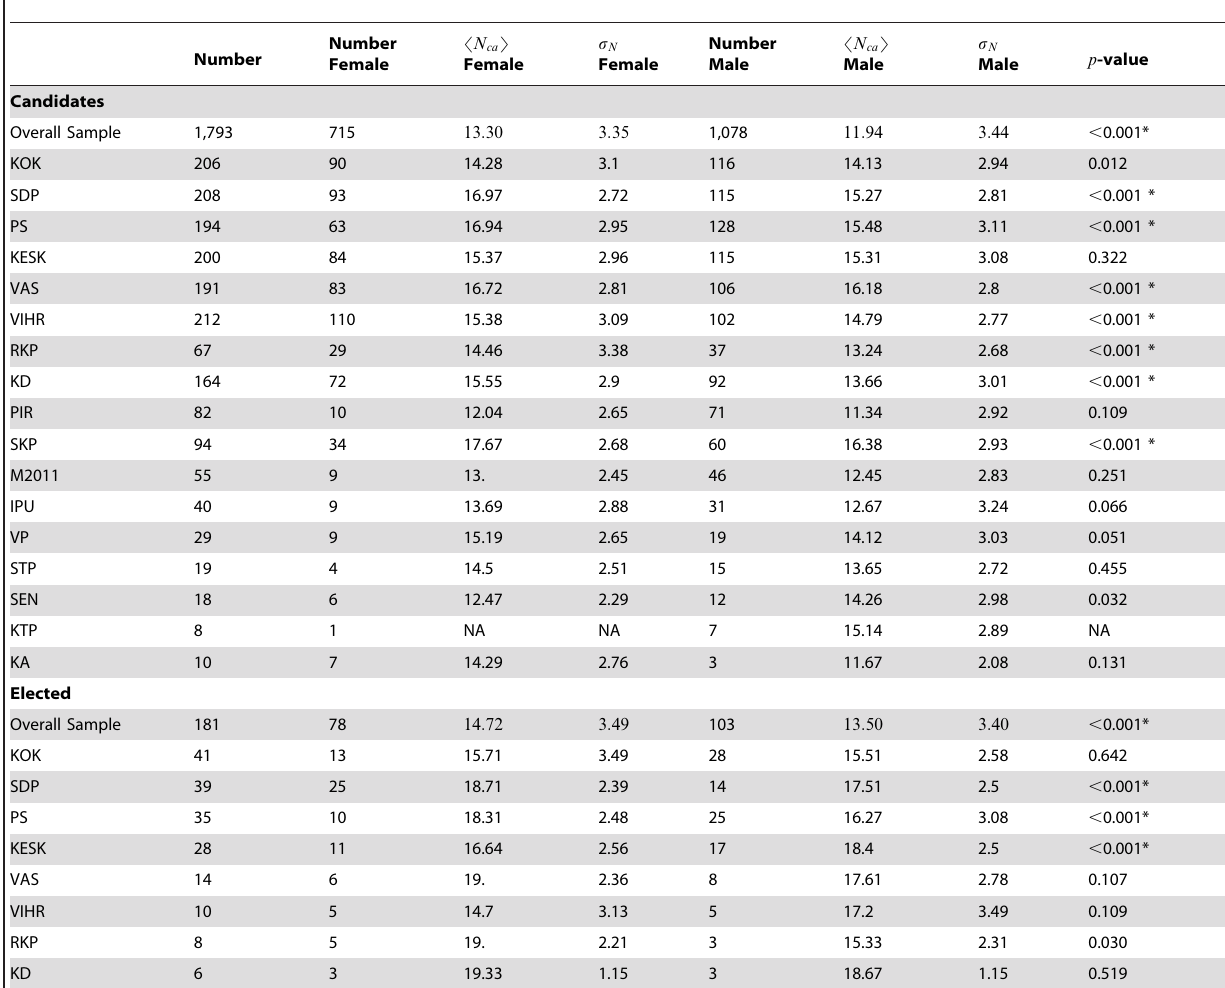
Table 1. Summary statistics of the degree of similarity of political profiles of females and males, for both candidates and elected members, disaggregated by